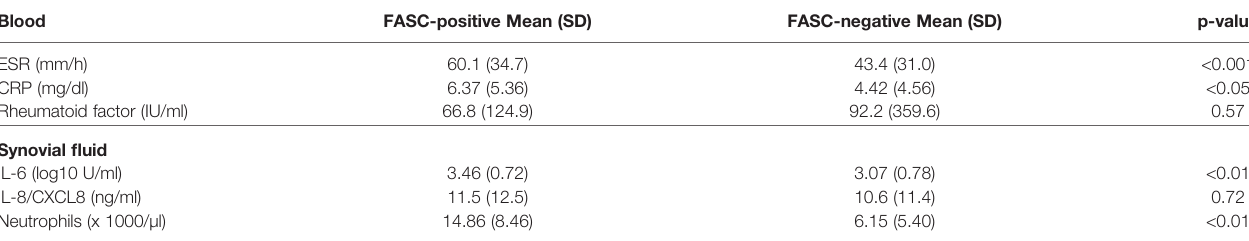
TABLE 1 | Correlation analysis between gelatinase activity and venous blood and synovial fl uid markers of in fl ammation.